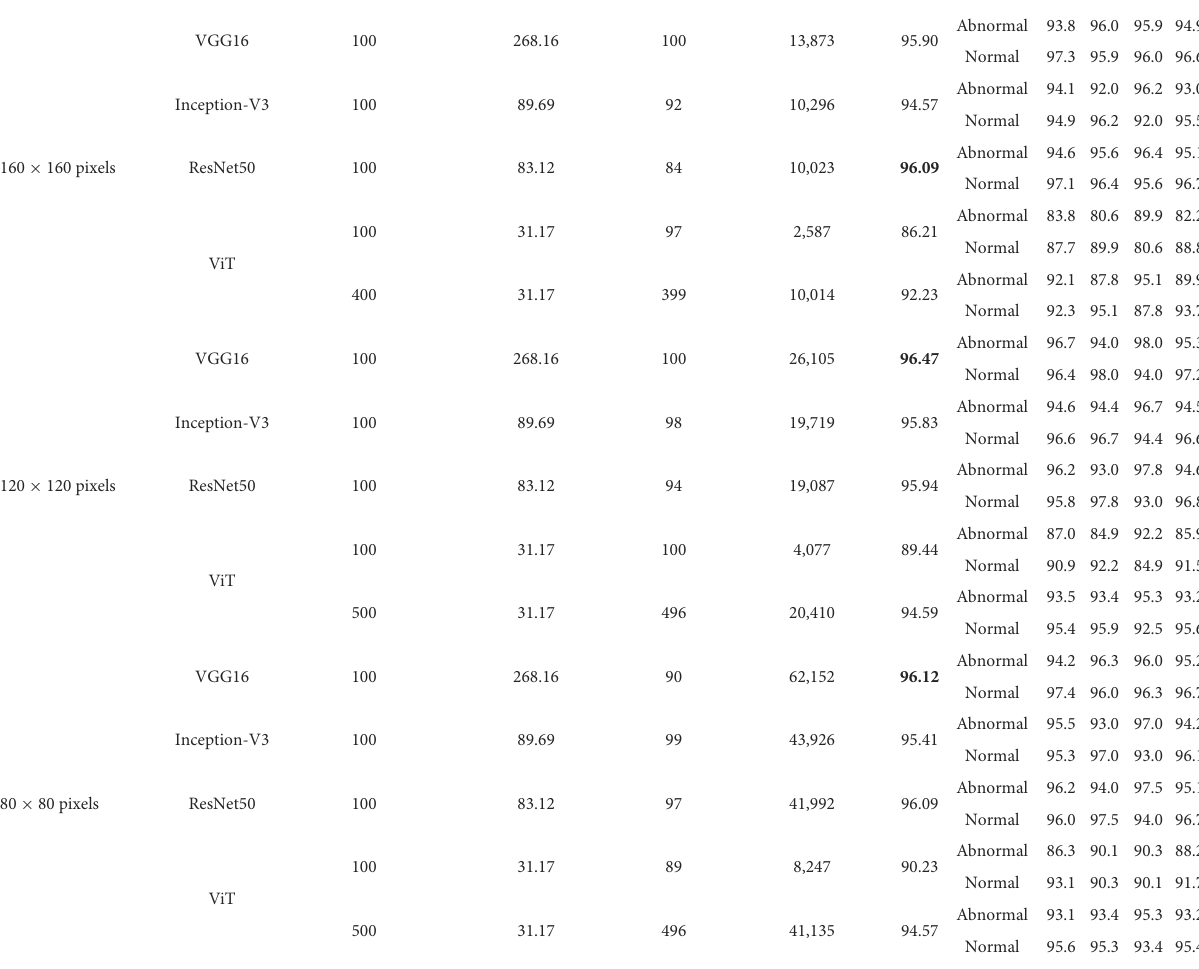
TABLE 6 Classification results of four deep learning classifiers on GasHisSDB [In (%)]. Sub-database